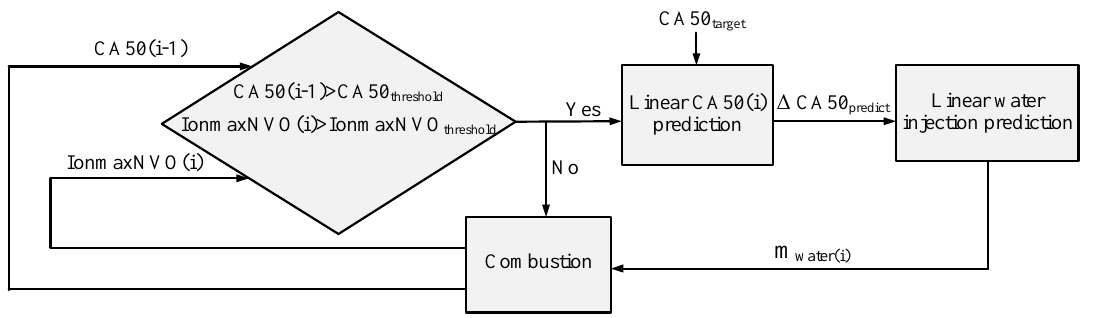
Figure 10. Structure of control algorithm.